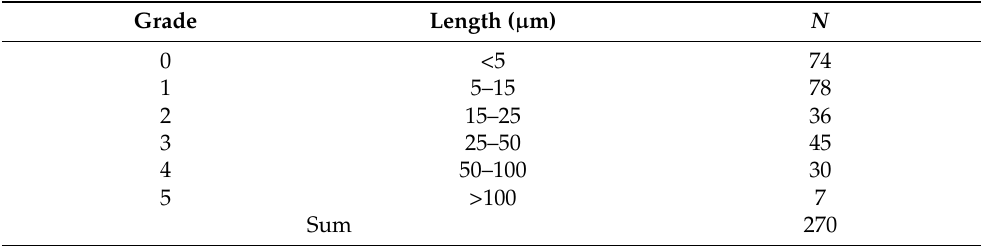
Table 2. Length classification statistics.